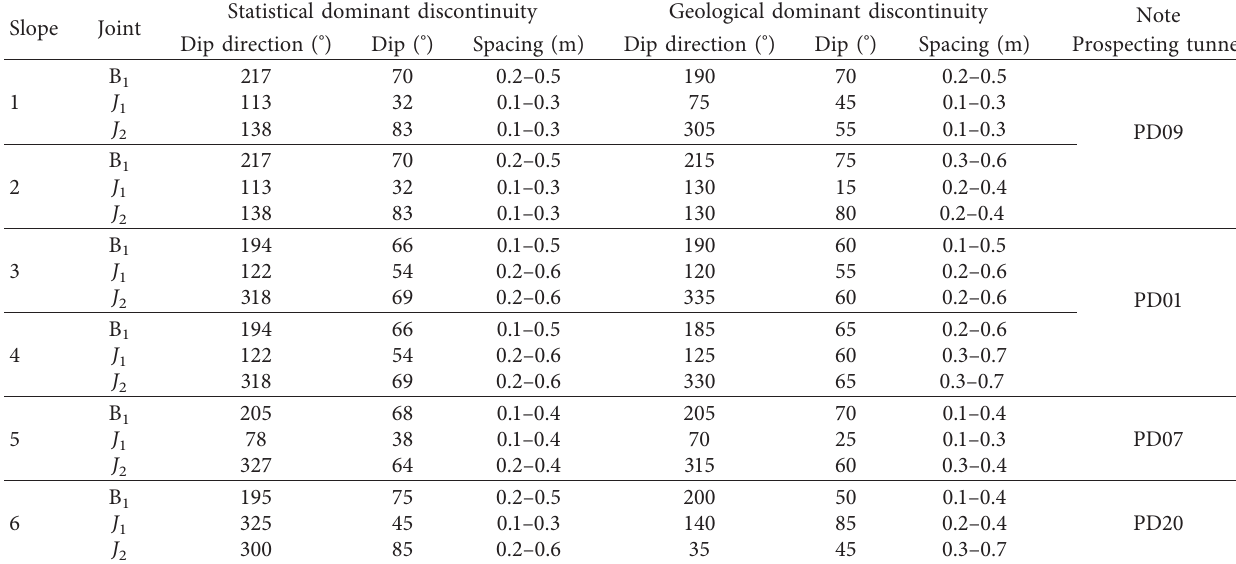
Figure 3: Contour plot of the field-surveyed discontinuity in the study area. Table 2: Characteristics of the main discontinuity sets in the surveyed